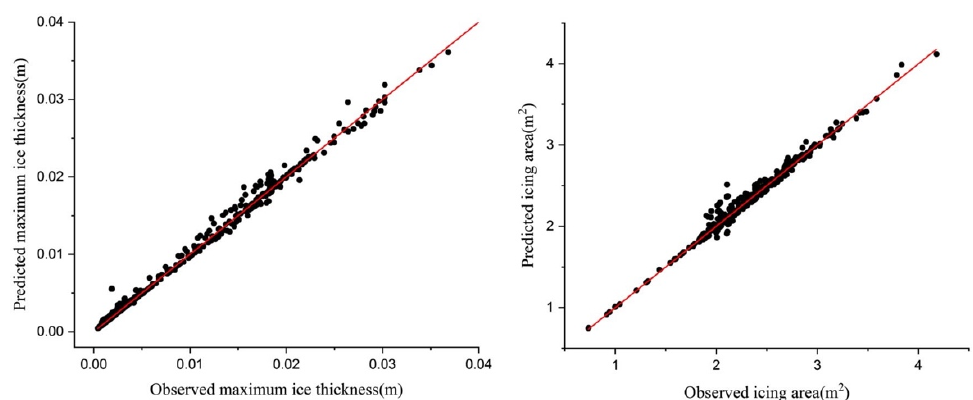
Figure 7. Scatter plot of observed results vs. predicted results. Left panel: maximum ice thickness; right panel: icing area [24].